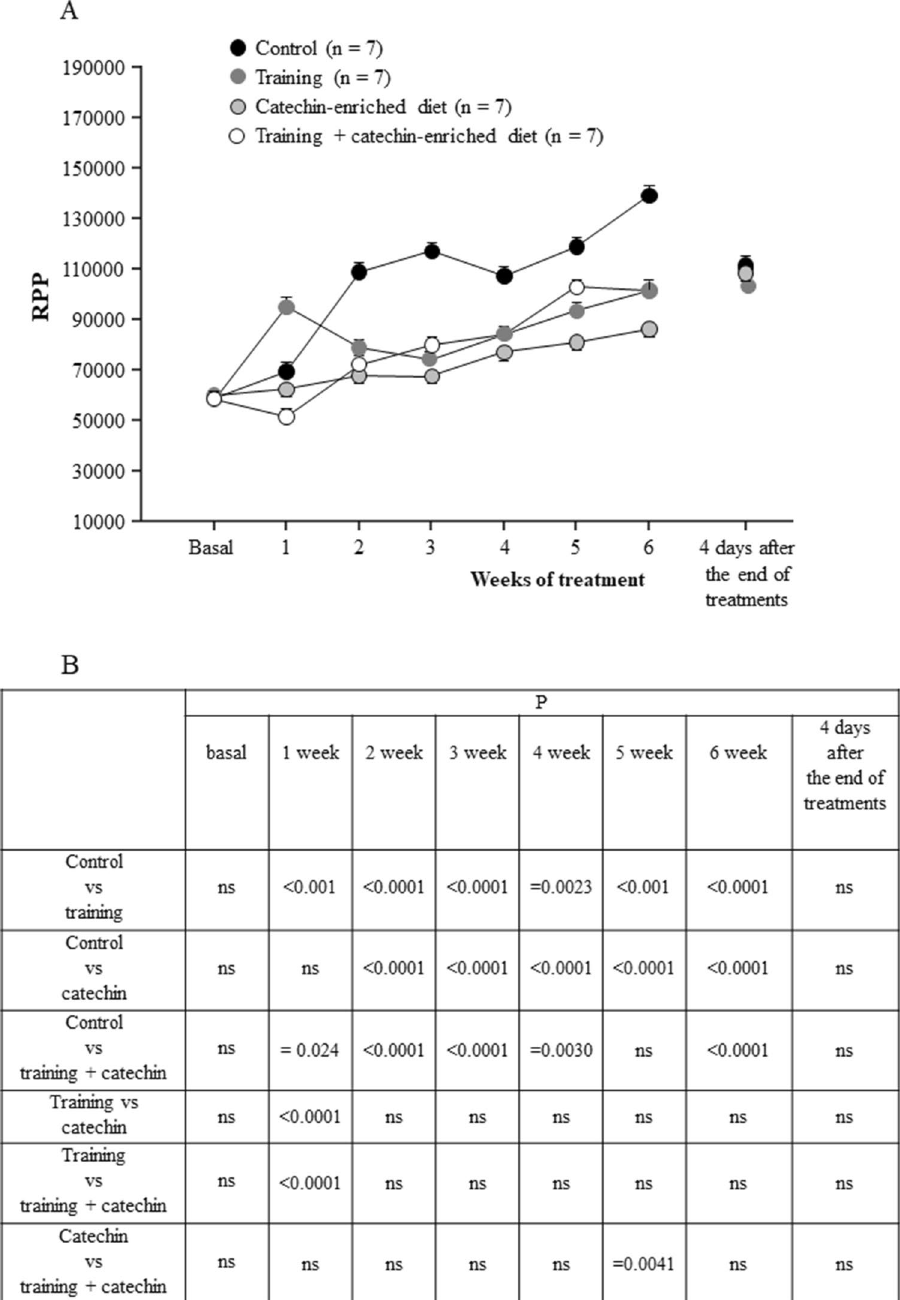
Figure 6. Time-course of rate pressure product (RPP, mean ± SEM) in the different groups of rats considered ( A ). Summary of statistical analysis results ( B